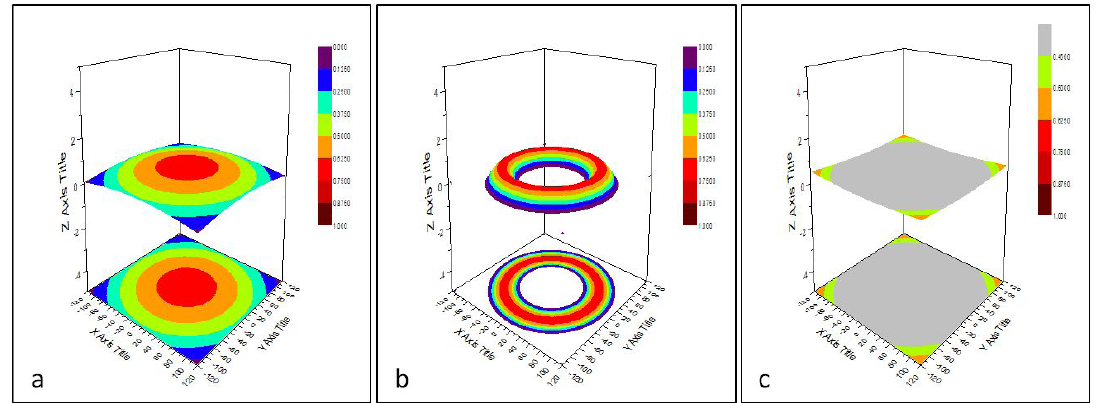
Figure 7. Distribution of platinum thin films: a. PtL, b. PtS , and c. Pt15.